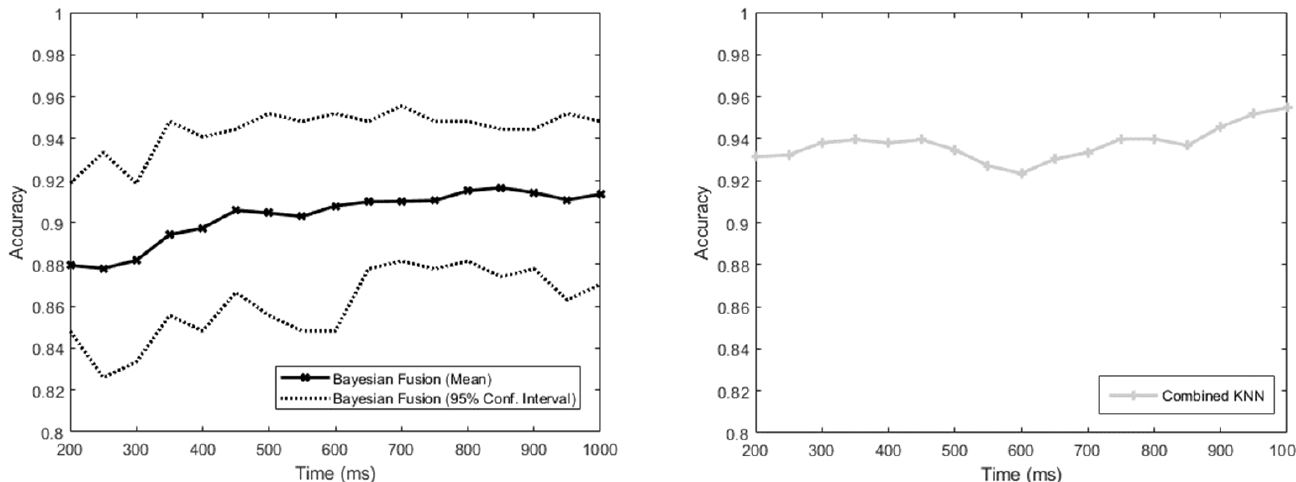
Figure 5. Graphs to show the accuracy of the intent-classification system against the time allowed to pass after the activity’s inception before classification was performed, up to the 1-second limit and with all 24 sensors active (no dropout). These graphs are shown separately to clearly illustrate the presence of a general trend for each algorithm, but comparisons between the two in this context should be avoided (see Section 4.1 for discussion on this). The Combined KNN method does not have confidence intervals, as all the sensors are included and there is no subdivision of the training data, so its performance is entirely reproducible.